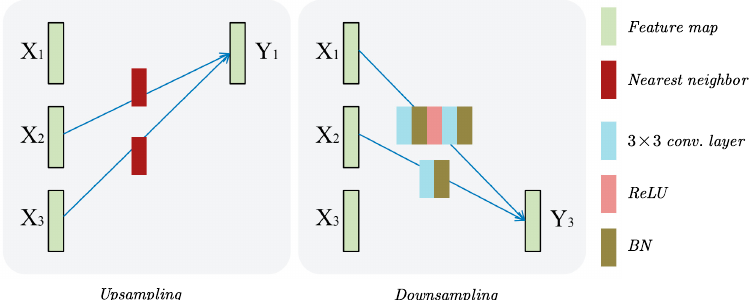
Figure 4. Schematic diagram of up-sampling and down-sampling between different feature layers in the multi-scale feature fusion stage.